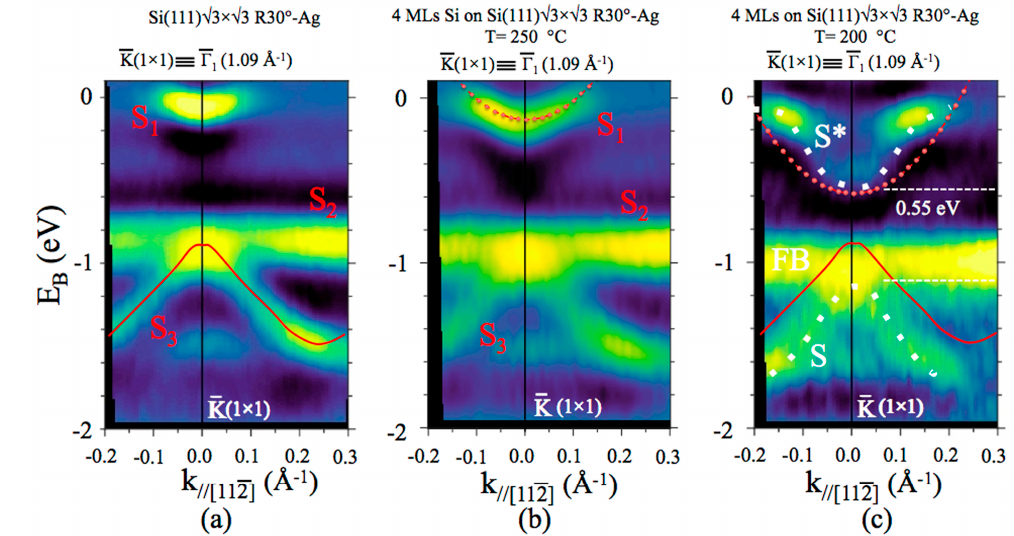
√ √ √ √ 3 × 3 R30 ◦ –Ag (a); 3 × 3 of √ √ √ 3–Ag ( b ), and 3 × 3 Si film grown at ~200 ◦ C on